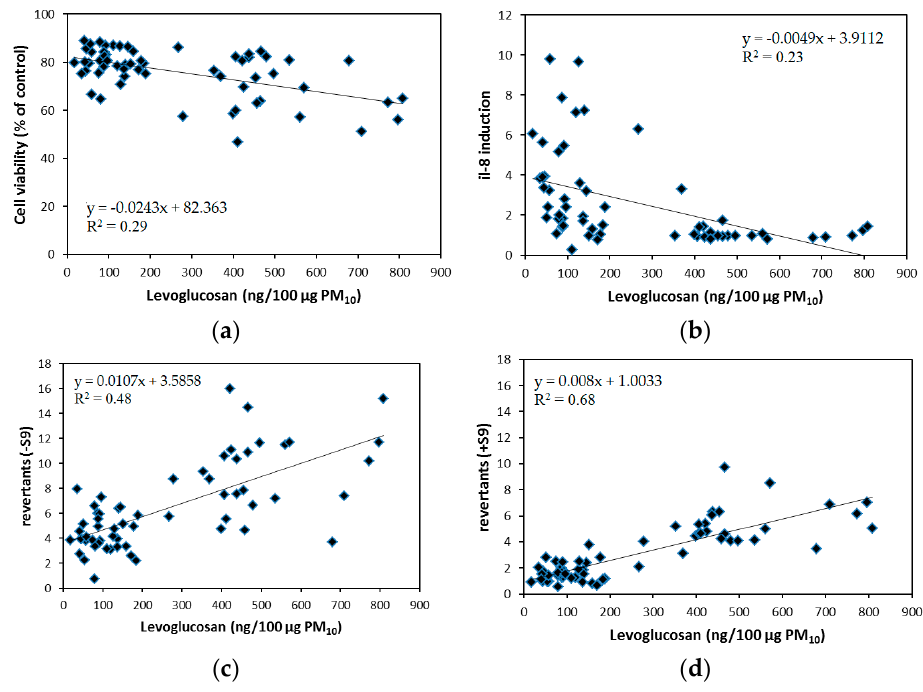
Figure 6. Scatterplots of selected chemical elements with biological responses at an exposure concentration of 100 µg PM 10 . Cell viability ( a ) is expressed as the percentage viable cells compared to the negative control. IL-8 induction ( b ) is expressed as the ratio of IL-8 production in exposed cells compared to unexposed Beas-2B cells. Direct ( c ) and indirect ( d ) mutagenicity are expressed as the number of revertants/100 µg PM 10 -equivalent.